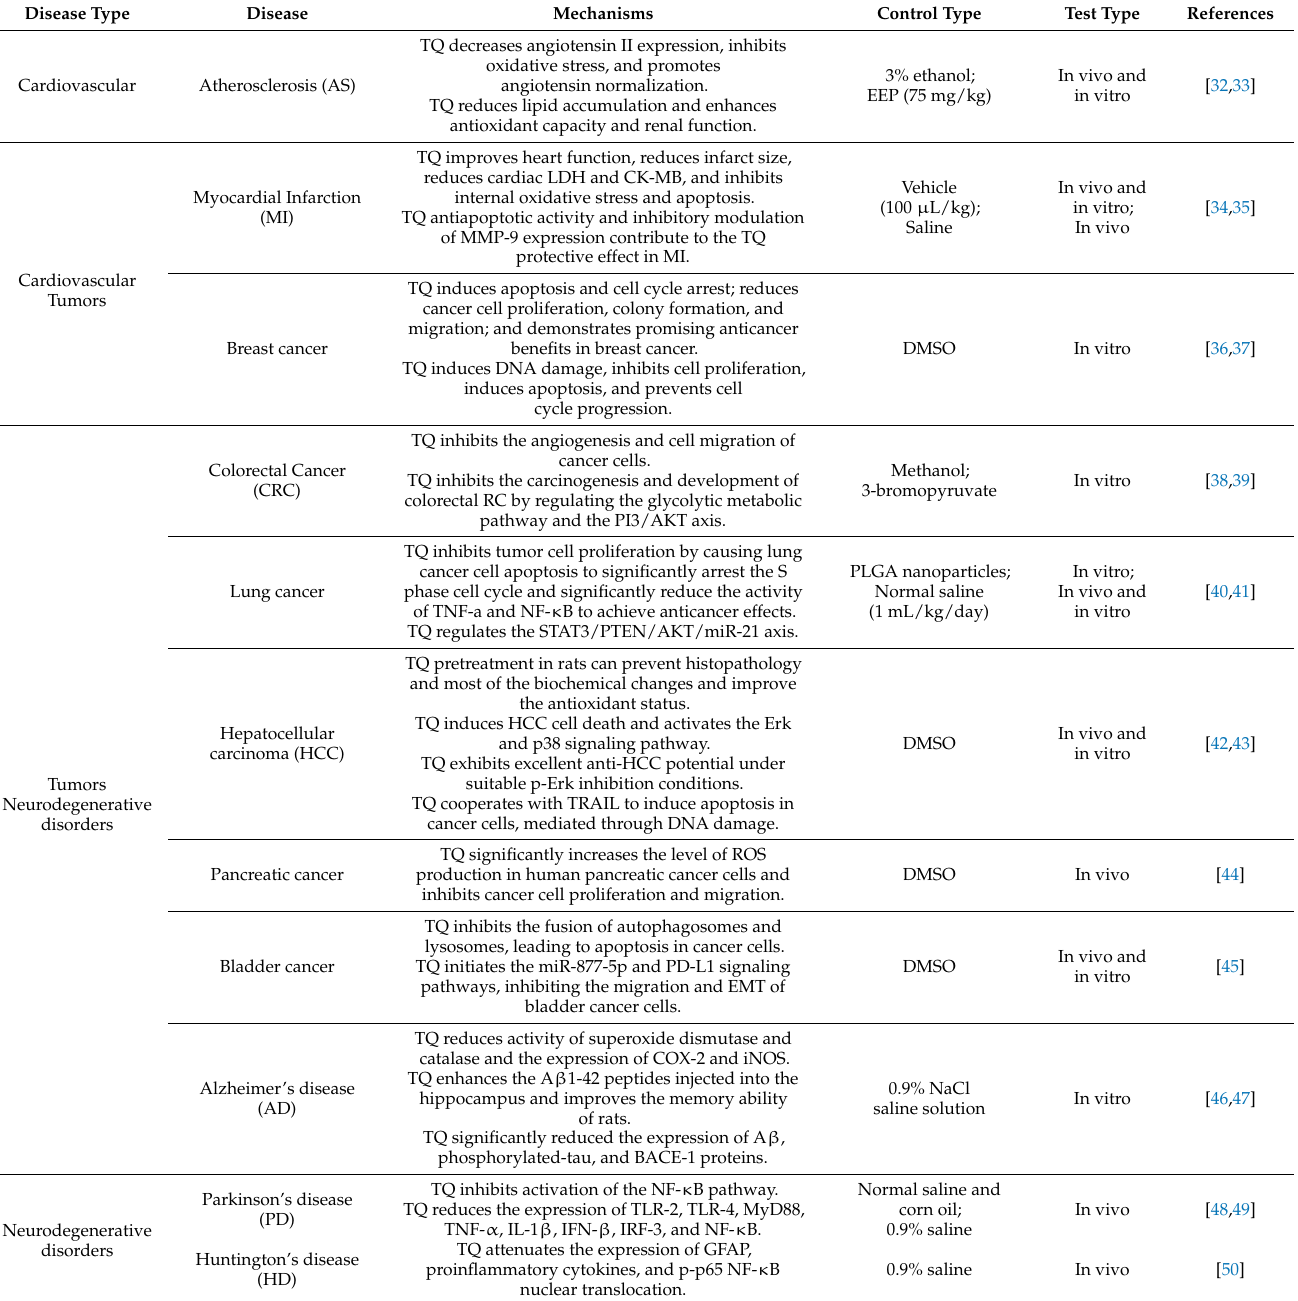
Table 1. The pharmacological activity and mechanism of TQ in various